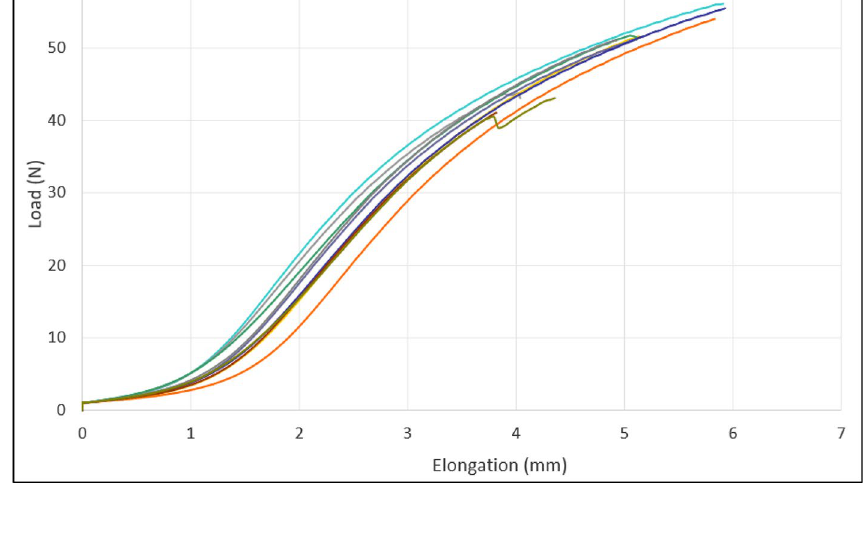
Fig. 39 Force elongation curves of individual specimen of paper